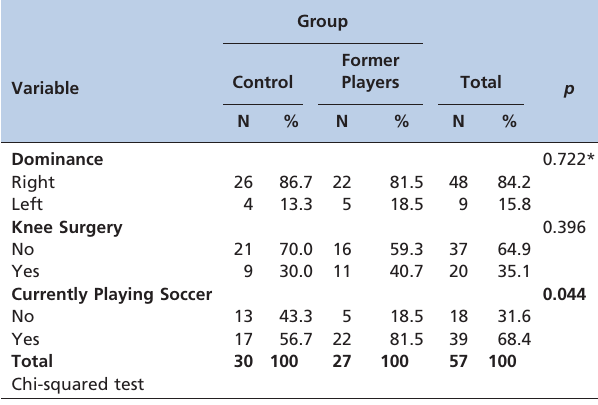
Table 1 - Demographic characteristics of the groups.